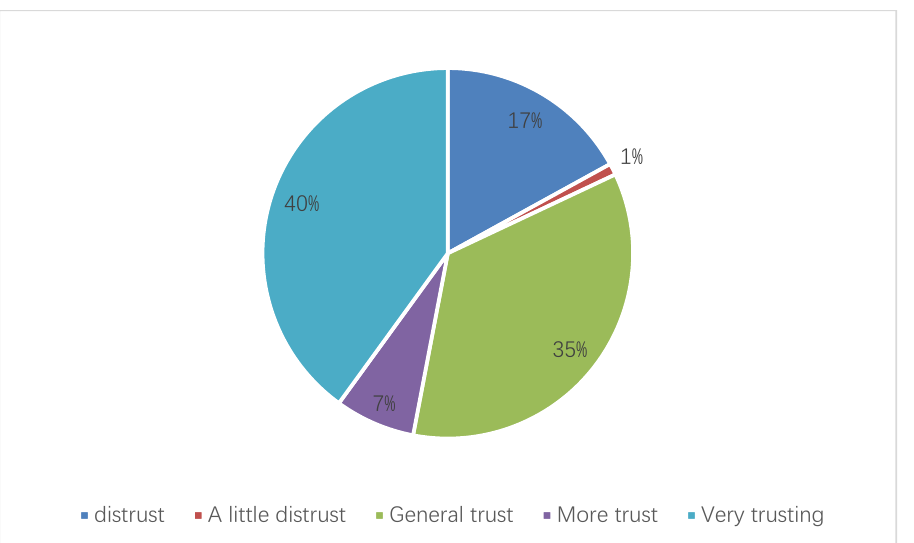
Figure 13. Consumer trust in organic agricultural products.